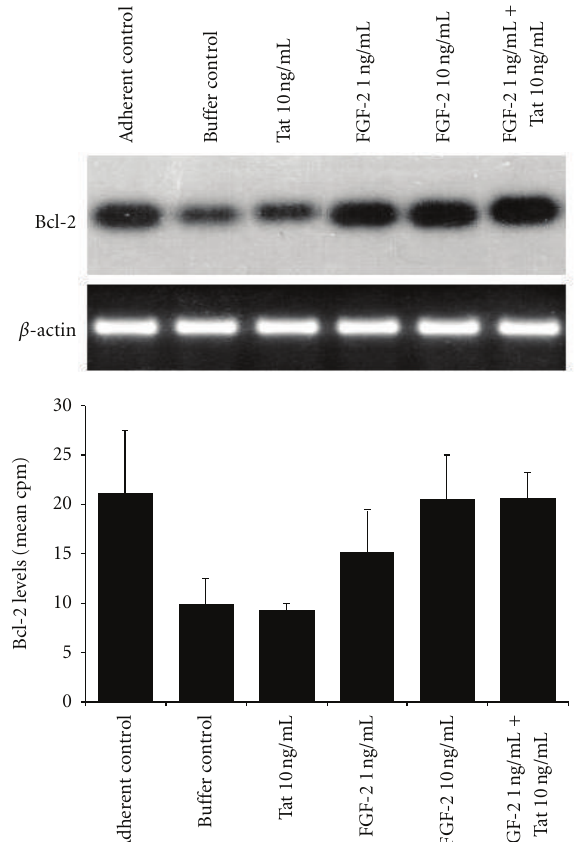
Figure 4: Protection of human endothelial cells from anoikis by FGF-2 alone or combined with Tat parallels the up-regulation of Bcl-2 expression. HUVECs were treated as described in the legend of Figure 2. Total RNA was extracted from the cells, and the Bcl-2 mRNA levels were analyzed by a housekeeping gene normalized RT-PCR assay. In the upper panel is the Southern blot hybridization of PCR products from a representative RT- PCR experiment performed with primers specific for Bcl-2. In the central panel is the β -actin RT-PCR amplification of the samples, showing that normalization of cDNA content resulted in β -actin PCR bands of identical size. In the lower panel is the quantification of Bcl-2 hybridization bands by Instant Imager from 3 independent experiments (average